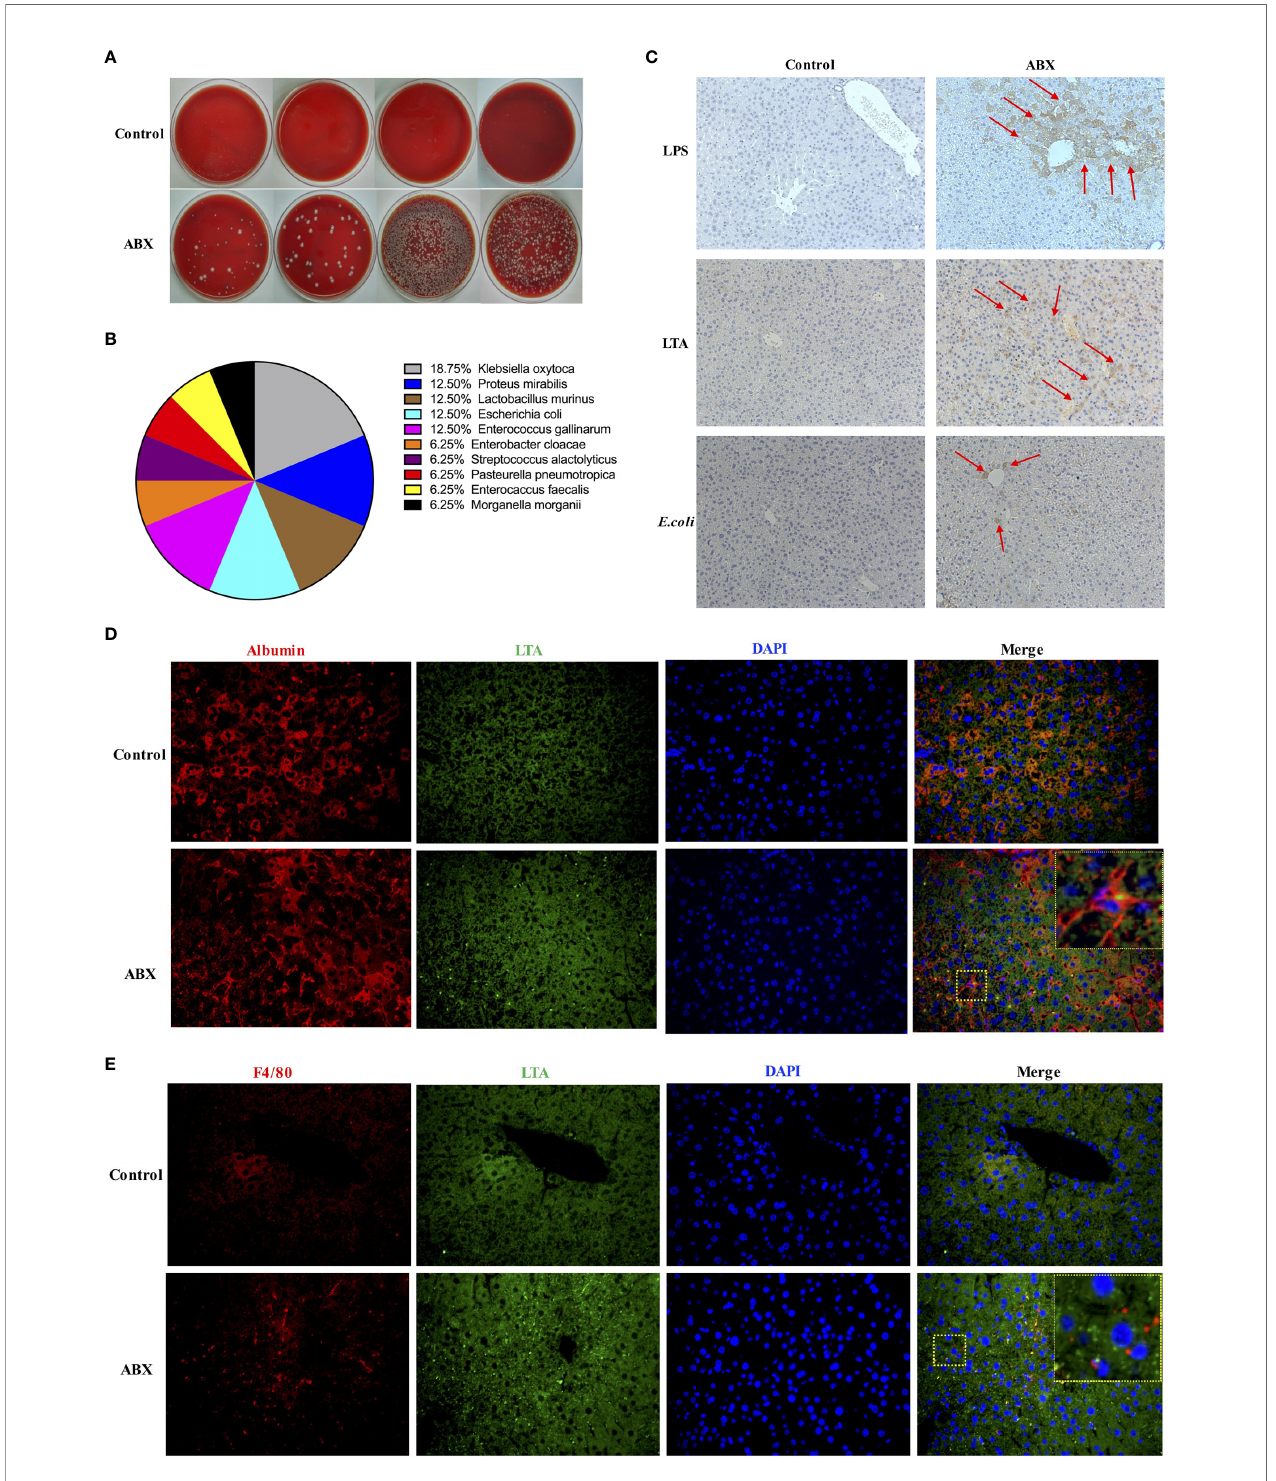
FIGURE 3 | Commensal bacteria translocated to the liver after gut microbiota depletion. (A) Bacterial colonies after overnight cultivation of liver homogenates from control and ABX mice on blood agar plates. (B) Composition of 16 identi fi ed colonies. (C) LPS, LTA, and E . coli deposits in liver tissue section as measured via IHC staining (200×). Immuno fl uorescence microscopy images showing LTA (blue, 400×) deposited in hepatocytes (D) and Kupffer cells (E) . Nuclei (green), hepatocytes and Kupffer cells (red). The boxed area in the slide is enlarged and shown in the inset. n =